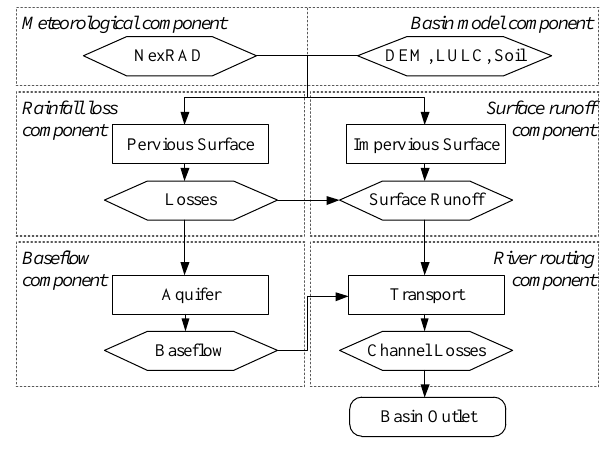
Fig. 2. Schematic of rainfall–runoff processes in Fig. 2 Schematic of rainfall-runoff processes in HEC-HMS 3